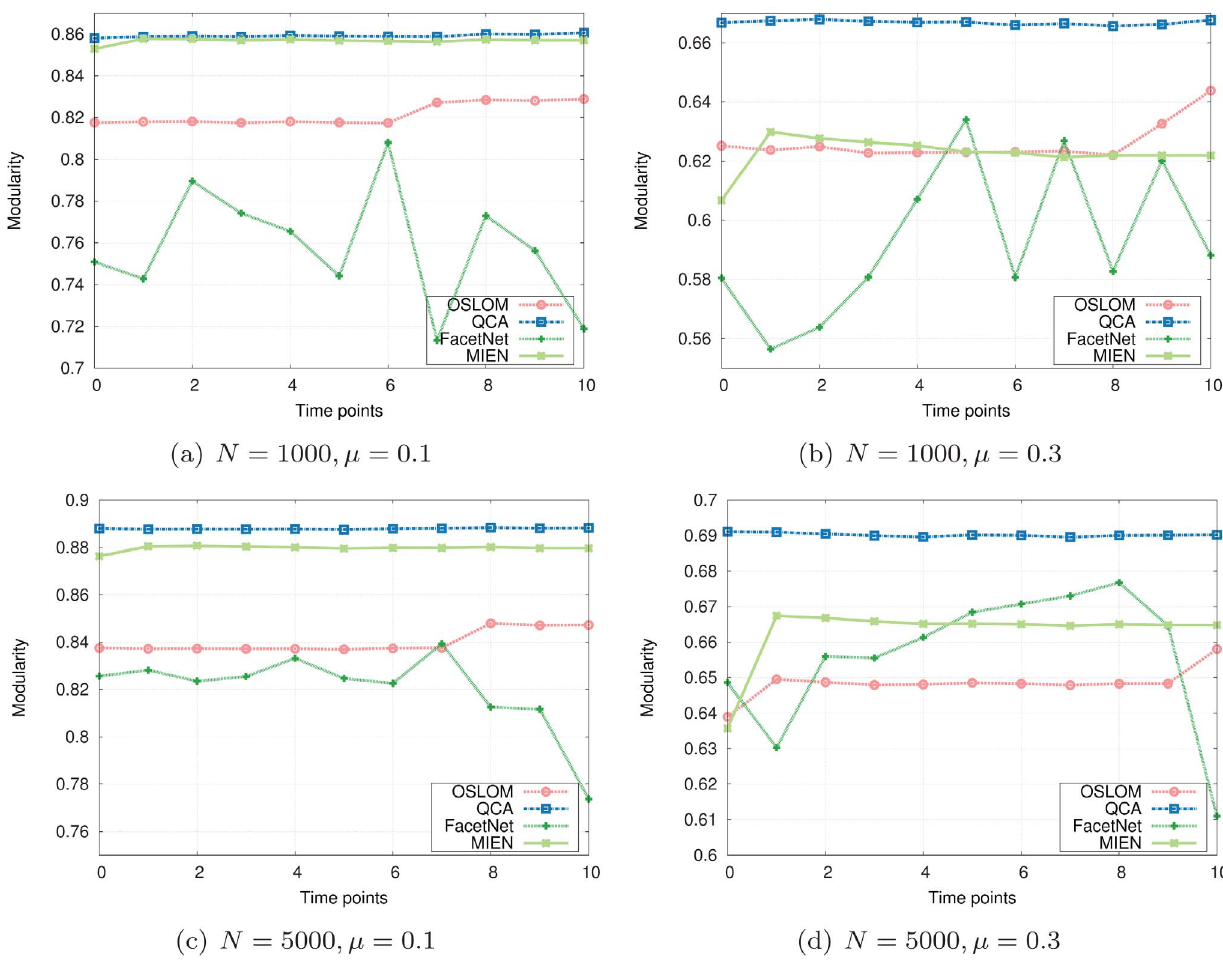
Figure 4. Modularity values on synthesized networks with known communities.